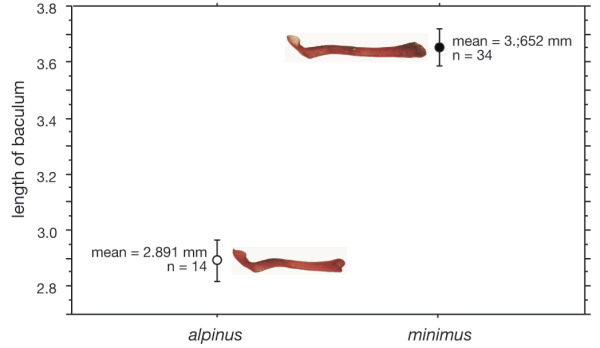
Mean length and standard error of baculum in specimens of T. alpinus and T. minimus in Sierra Nevada, CA. Photograph of baculum of each species shown at right of data point.